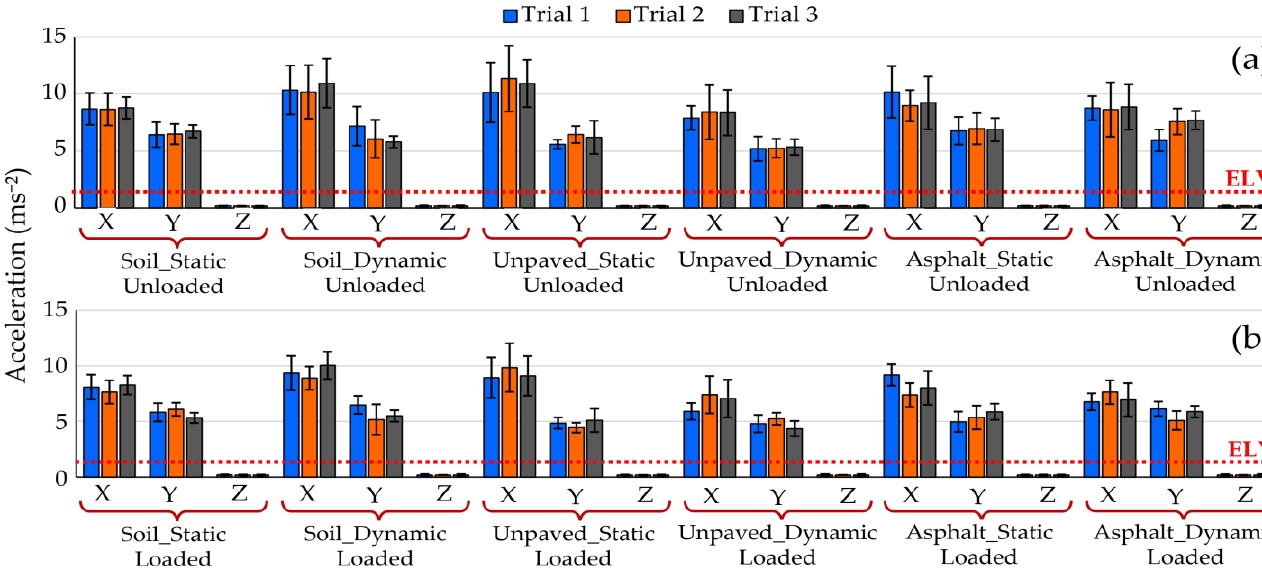
Figure 6. Vibration exposures measured at the operator seat for different driving surfaces and operating statuses under the unloaded ( a ) and loaded ( b ) conditions. ELV: exposure limit value (1.15 ms −2 ).